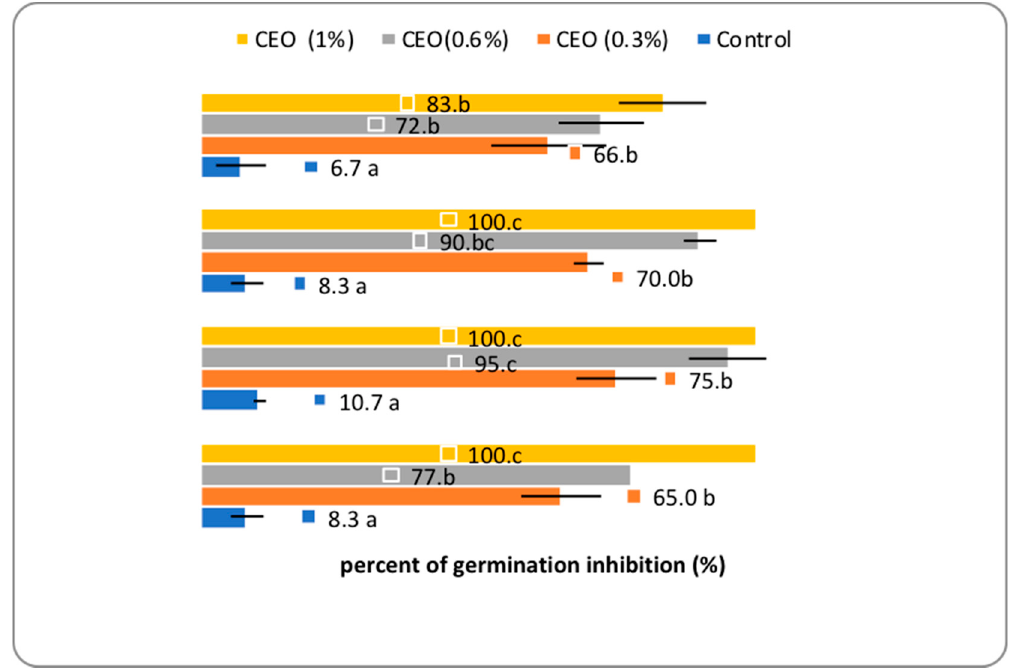
Figure 4. The percent of seed germination inhibition in the presence of CEO (1%, 0.6%, and 0.3%). Between the mean values followed by different letters, there are statistical differences assured for p < 0.05 by t -Test (n = 3) WHEAT, ( Triticum aestivum ), EGAL ( Echinochloa crus-galli ), CALB ( Chenopodium album) , and ARET ( Amaranthus retroflexus ).